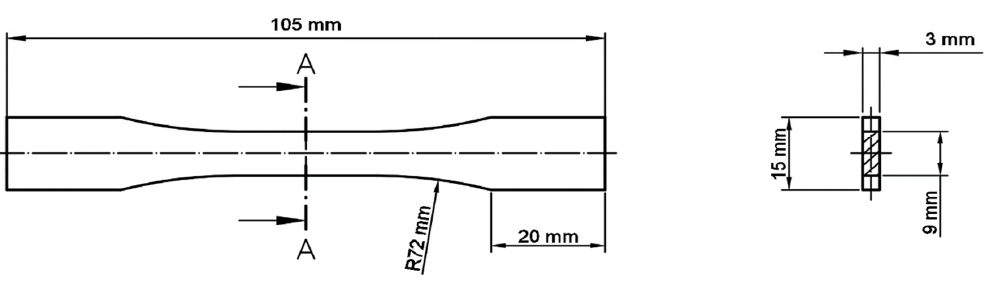
Figure 6. Sample dimensions basing on the ASTM E466 96 standard.